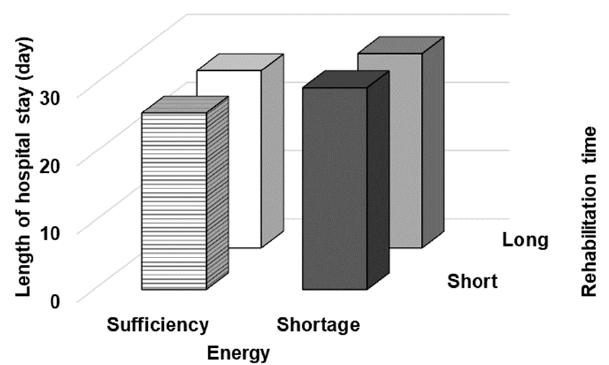
Figure 3. Comparison of length of hospital stay. The patients were divided into four categories based on their energy intake during the first week of hospitalization (sufficient/shortage) and rehabilitation time (long/short). Black bar represents “Short × Shortage”, gray bar represents “Long × Shortage”, horizontally striped bar represents “Short × Sufficiency”, and white bar represents “Long × Sufficiency”. There were no significant differences among the groups ( p = 0.104).